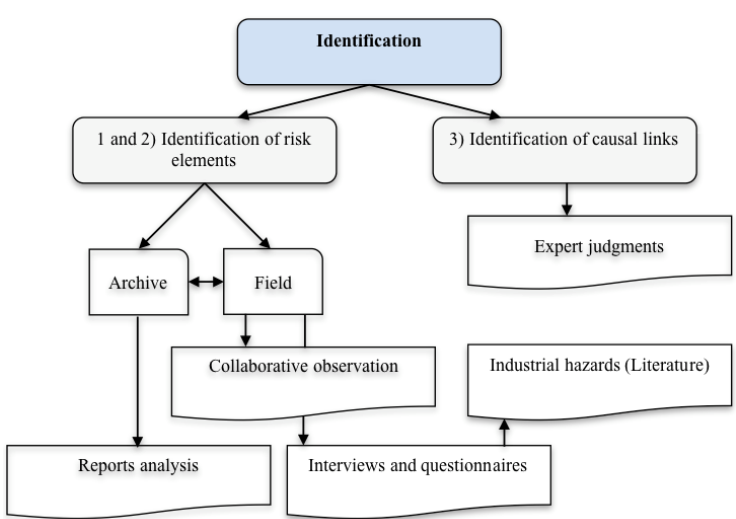
Figure 3. Identification phase of the risk-factor-based